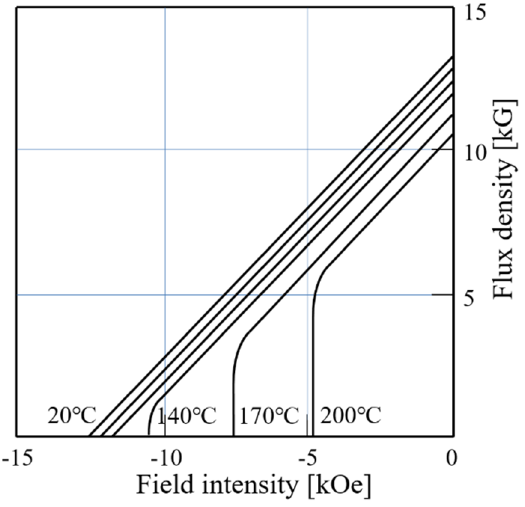
Figure 2. Demagnetization curves of N39UH grade magnets.